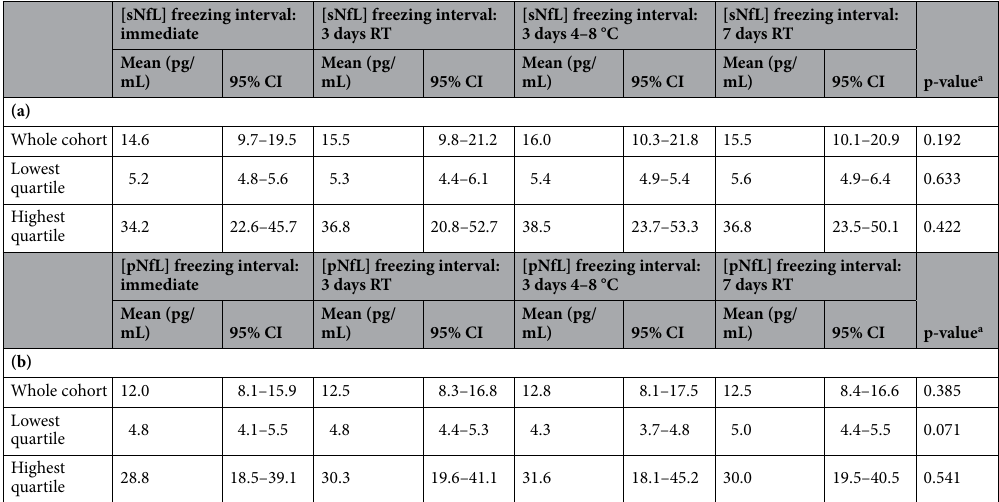
Table 2. Comparison of NfL concentrations at different freezing intervals. Mean values and 95% confidence intervals (95% CI) for (a) serum neurofilament light chain (sNfL) and (b) plasma neurofilament light chain (pNfL). CI confidence interval, pNfL plasma neurofilament light chain concentration (pg/mL), RT room temperature, sNfL serum neurofilament light chain concentration (pg/mL). a Calculated by repeated measurement